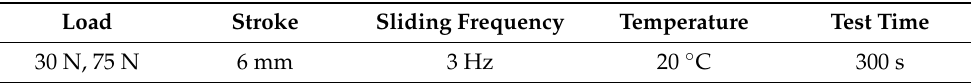
Table 1. Experimental conditions.